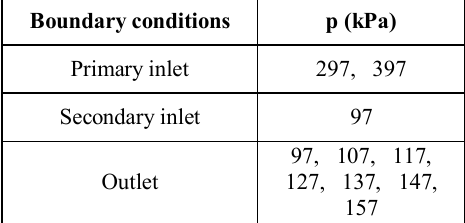
Table 2. Boundary conditions of the ejector model Boundary conditions